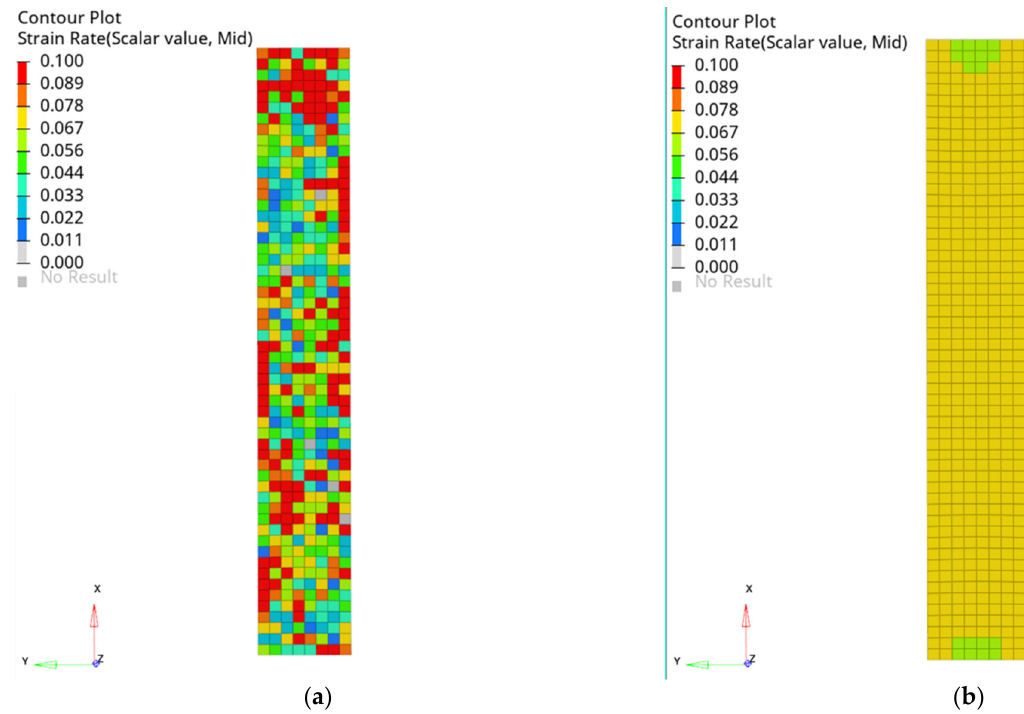
Figure 7. Visualization of strain rates within a tensile test specimen in the elastic domain. Unfiltered ( a ) and filtered ( b ) using the exponential moving average filter.